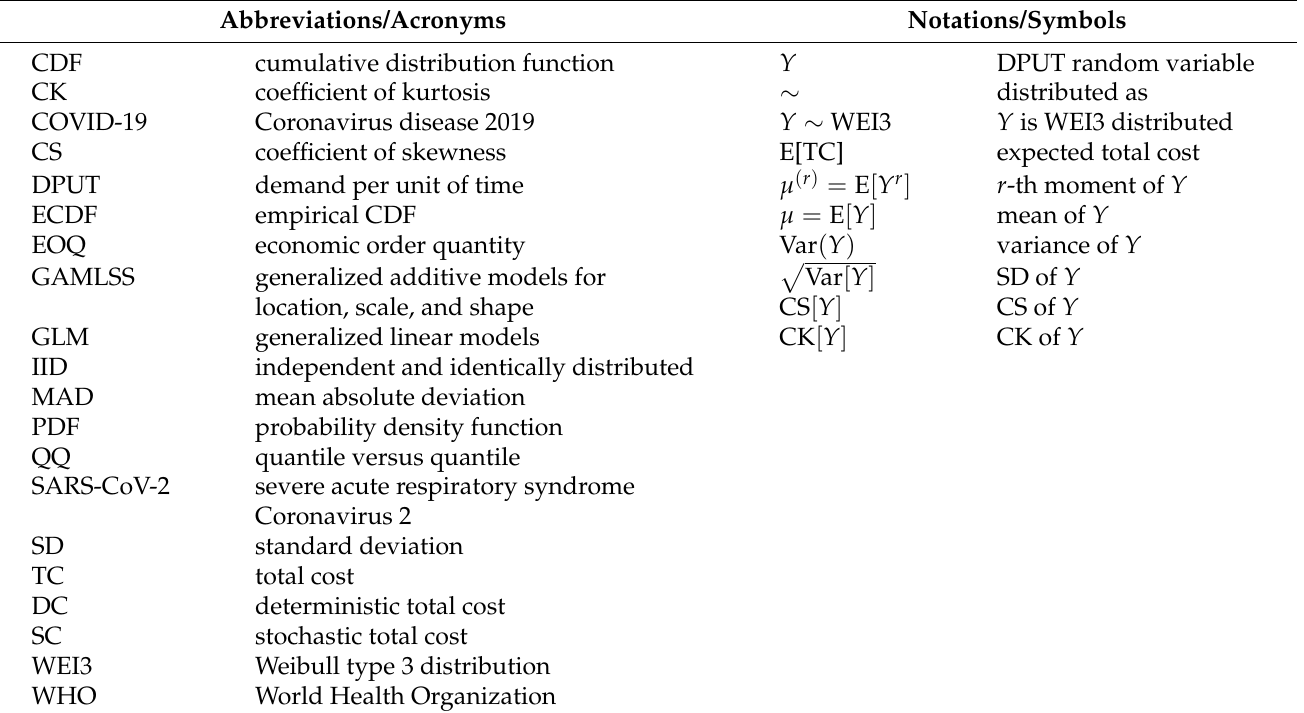
Table 1. Abbreviations, acronyms, notations, and symbols employed in the present